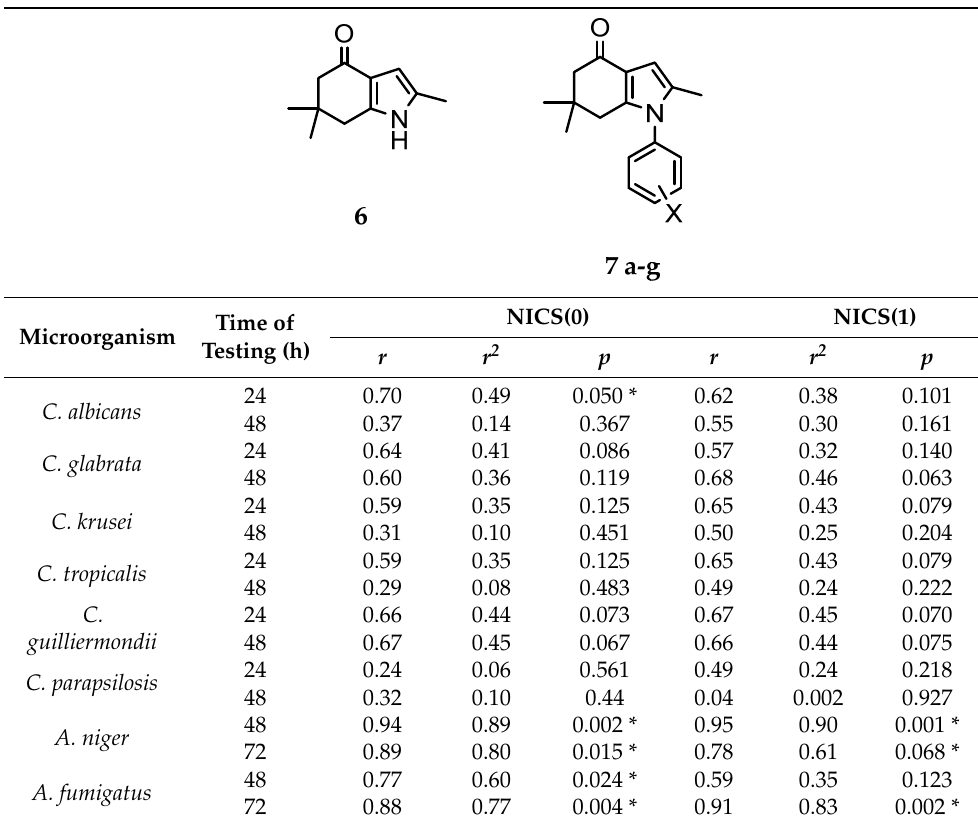
Table 2. Pearson and determination coefficients for simple linear regression NICS(0) and NICS(1) for series I: compounds 6 and 7g.